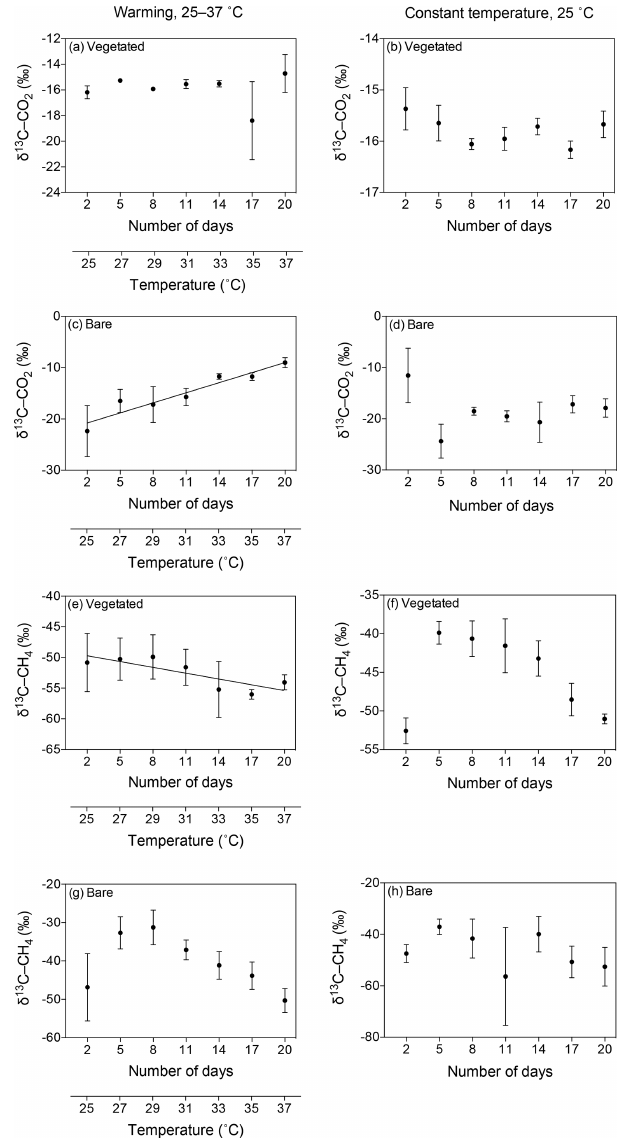
Figure 6. Mean ± SE isotopic signature of CO 2 ( δ 13 C-CO 2 ) and CH 4 ( δ 13 C-CH 4 ) in the communities experiencing warming from 25 to 37 ◦ C (left) and the communities maintained at 25 ◦ C (right). (a–d) δ 13 C-CO 2 is shown for the (a, b) vegetated and (c, d) bare sediments over the experimental period (number of days since the onset of the experiment). (e–h) δ 13 C-CH 4 is shown for the (e, f) vegetated and (g, h) bare sediment over the experimental period. The second x axis indicates the temperature increase for the community experiencing warming.